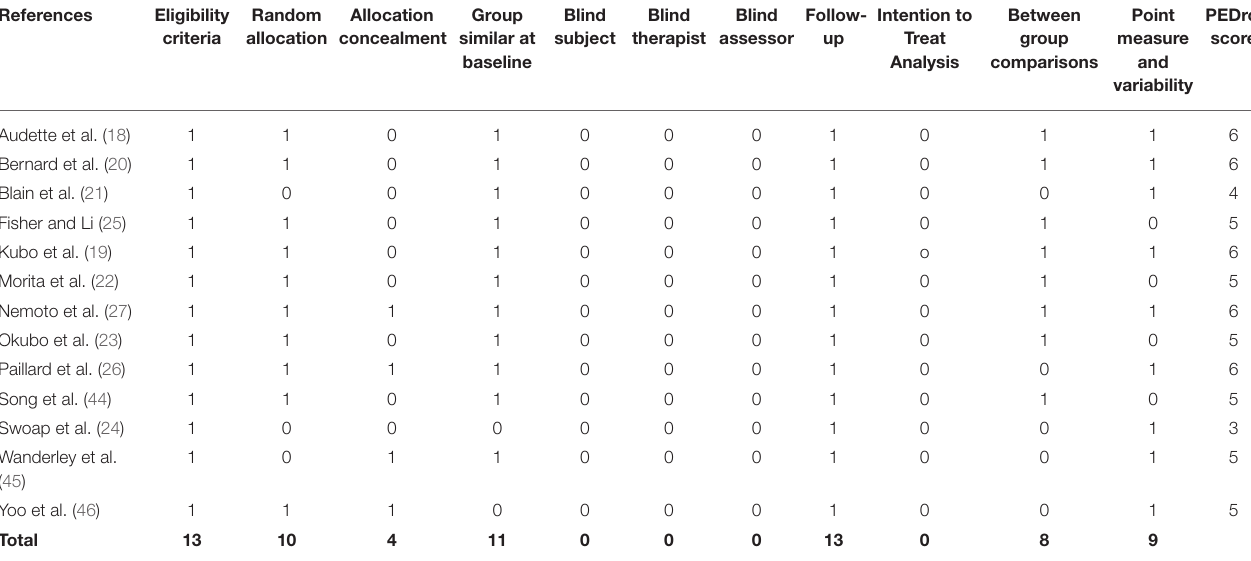
The bold values means summary of the quality evaluation of all